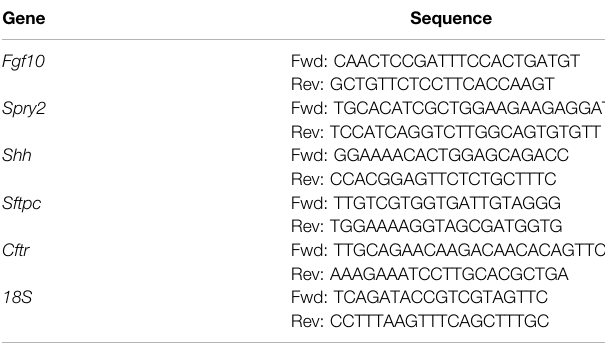
TABLE 1 | Primer sequences used for quantitative RT-PCR. Gene